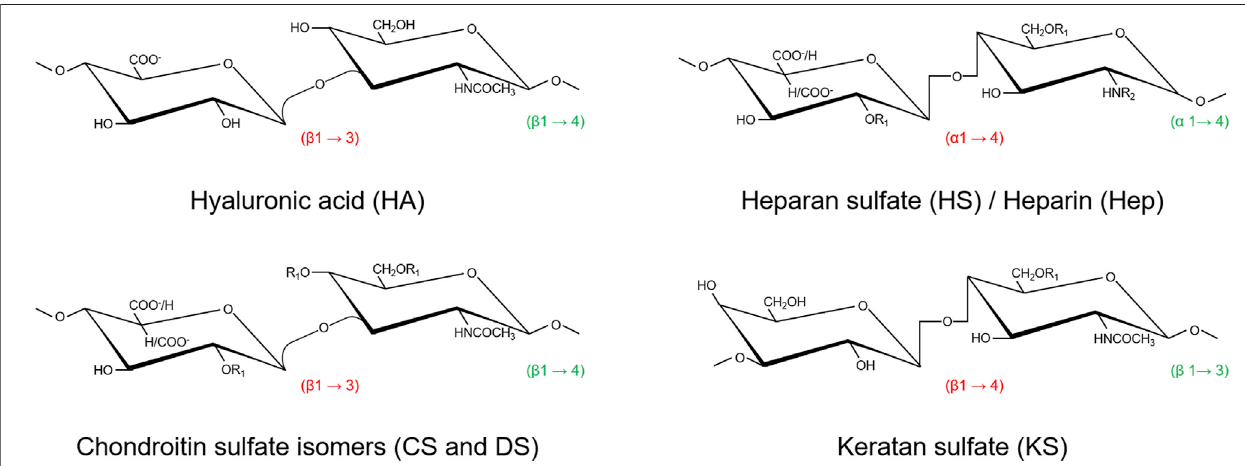
FIGURE1| StructuresoftherepeatingdisaccharideunitsrepresentativeofthesixGAGsclasses[modi fi edfrom(Vyniosetal.,2002)].BothDSandHS/Hepareco- polymersoftwotypes ofdisaccharide repeatswhere glucuronate isvariably substituted byits carbon-5 epimer iduronate.Hep hasboth ahigher degree ofsulfation and epimerizationthan HS.ExceptforHA,sulfation mayoccurinseveralpositions,thus givingthese glycansacharacteristichigh negative charge.Saccharidesarereported aschairconformations.Con fi gurationsoftheO-glycosidicbondsarereportedinred(withindisaccharideunits)andingreen(betweenadjacentdisaccharideunits). R 1 (cid:1) SO 3 − ; R 2 (cid:1) COCH 3 /SO 3 − .